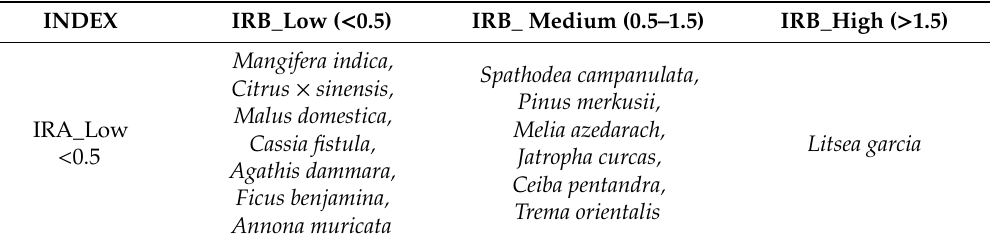
Figure 10. Examples of root-to-shoot relations at the four classification thresholds in Table 4. The IRB for a tree with stem diameter of 10 and 6 horizontal roots of 5 cm diameter is 6 * 5 2 / 10 2 = 1.5, while that for a tree with 5 roots of 3.16 cm is 5 * 3.16 2 / 10 2 = 0.5. Table 4. Two-way classification of trees based on rooting indices IRA (Index of Root Anchoring) and IRB (Index of Root Binding soil particles) classified by lower and upper quartiles of their